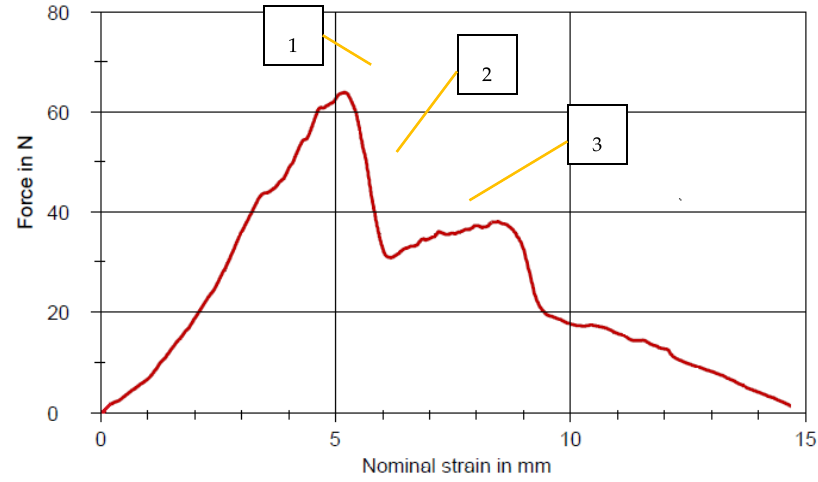
Figure 7. Typical force versus fibre displacement curve for the pull-out test.